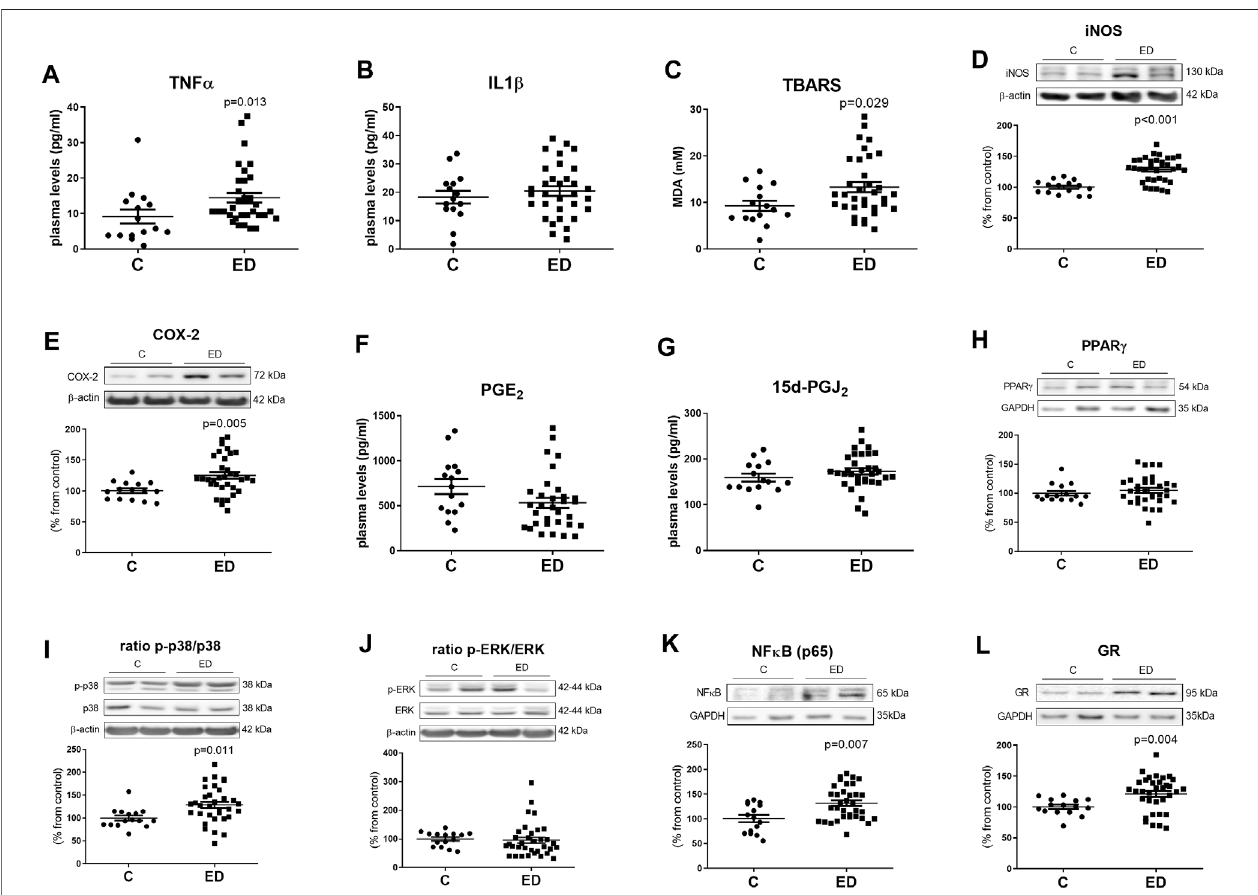
FIGURE 1 | Plasma levels of in fl ammatory cytokines and oxidative/nitrosative markers (A – C) , protein expression levels of in fl ammatory and oxidative/nitrosative enzymes in the cytosolic fraction of PBMCs (D,E) , plasma levels of prostaglandins (F,G) , protein expression levels of in fl ammatory MAPKs in the cytosolic fraction of PBMCs (I,J) and protein expression levels oftranscriptionfactors (H,K) involved inin fl ammationor receptors involved inthestressresponse (L) in thenuclear fraction of PBMCs. Data are expressed as mean ± SEM on TNF α (A) , IL1 β (B) , TBARS (C) , iNOS (D) , COX-2 (E) , PGE 2 (F) , 15d-PGJ 2 (G) , PPAR γ (H) , p-p38/p38 (I) and p-ERK/ERKratio (J) ,NF κ Bp65 (K) andGR (L) betweeneatingdisorders(ED)andcontrol (C) groups(ED n =34,C n =15).IntheWesternblotsthedensitometricdataof the respective band of interest were normalized by β -actin in the cytosolic extract or by GAPDH in the nuclear extract (lower bands). Data were analyzed using the D ’ Agostino and Pearson normality test to assess Gaussian distribution, followed by an unpaired two-tailed t test. When data did not follow a Gaussian distribution, a Mann-Whitney test was performed; a p < 0.05 was considered statistically signi fi cant.